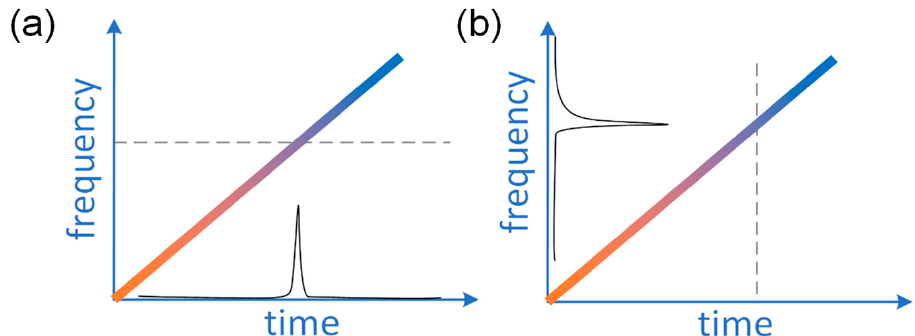
Figure 2. The operation principle of an FDML fiber laser from the viewpoint of ( a ) a single wavelength and ( b ) a given time.